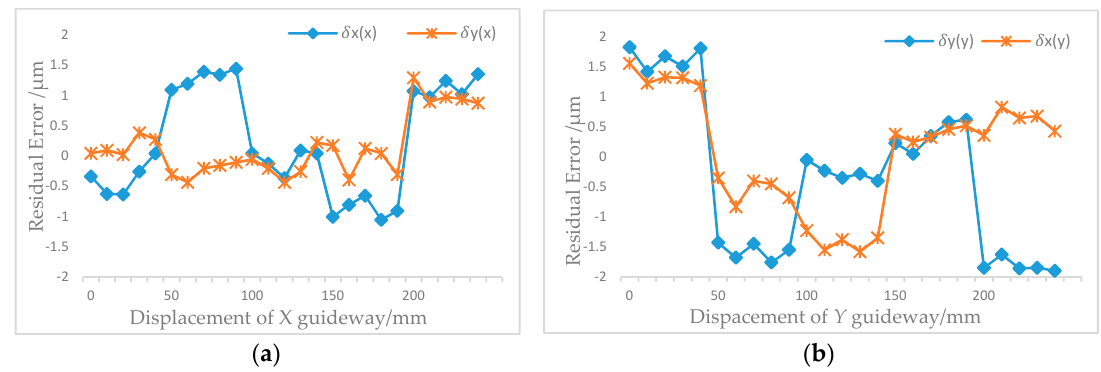
Figure 12. Residual errors of the proposed system: ( a ) Residual error of δ x ( x ) and δ y ( y ); ( b ) Residual error of δ y ( x ) and δ x ( y